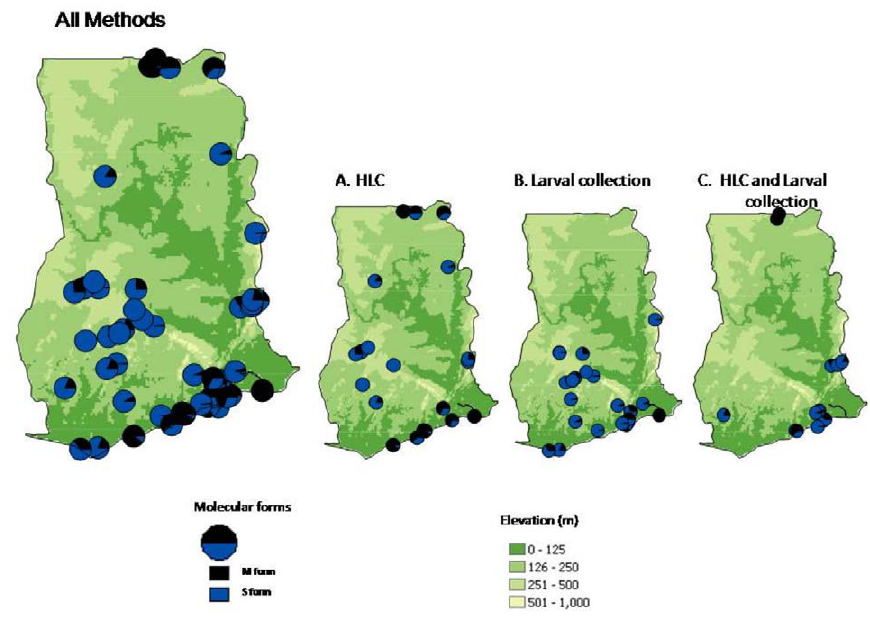
Figure 2. Distribution of An.gambiaes.s molecular form by collection methods.